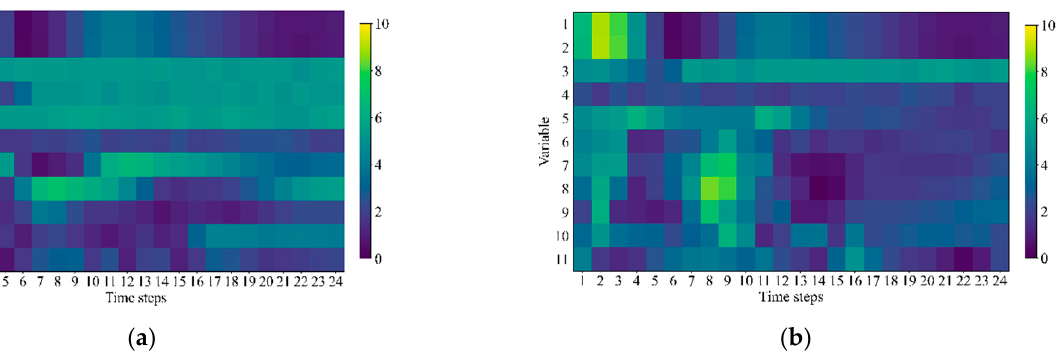
Figure 10. Distance-coded heat map of working condition 4. ( a ) Heat map of operating parameters of atmospheric two-line products. ( b ) Heat map of operating parameters of vacuum two-line products.